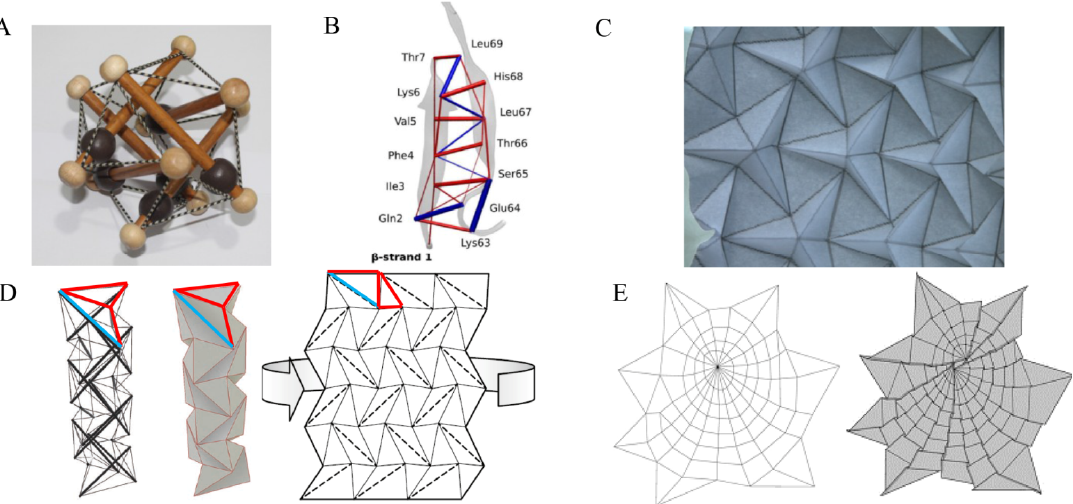
Figure 9. Tensegrity structures. ( A ) A tensegrity toy. The beams are connected to cables, which keep the structure under tension. ( B ) Protein structure: mean inter-residue forces for β -strand 1 in a β -sheet protein structure. The blue lines indicate pressure, and the red lines tension (Reprint from [47] with permission from PLOS Computational Biology). Origami models: ( C ) A folded model of an origami tessellation. ( D ) 3D tensegrity model (Left), its folded origami polyhedron analog (Center), and the polyhedron crease pattern (Right) (Reprint from [48] with permission from Heldermann Verlag). ( E ) Spider web tensegrity (Left) and its folded origami model analog (Right) (Reprint from [49] with permission from CRC